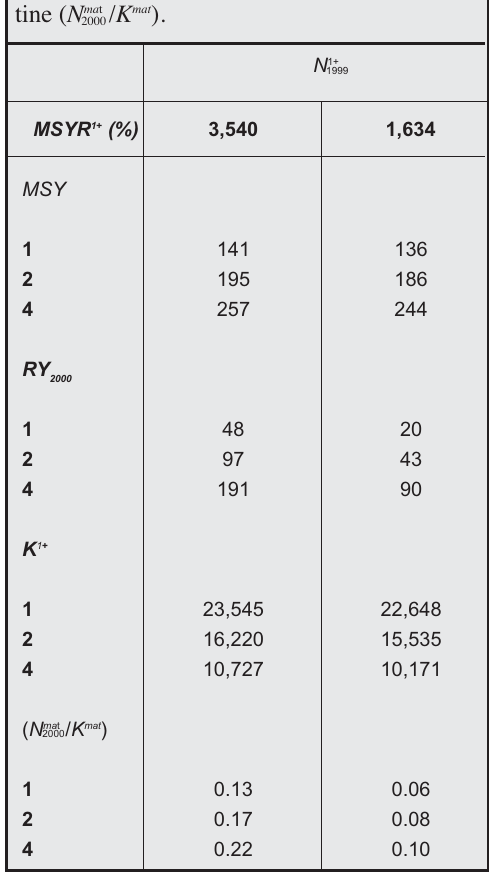
seem a particular problem, as the cv’s given for these estimates (Heide-Jørgensen et al. 1993, , 2000